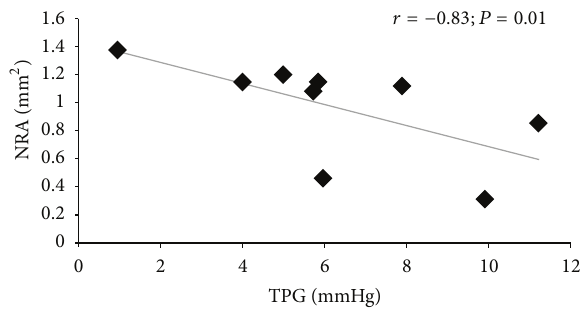
Figure 1: Correlation between translaminar pressure gradient and neuroretinal rim area in normal tension glaucoma patients. ∗ Spearman’s correlation. Significance level 𝑃 < 0.05 . r : correlation coefficient, TPG: translaminar pressure gradient, NRA: neuroretinal rim area.